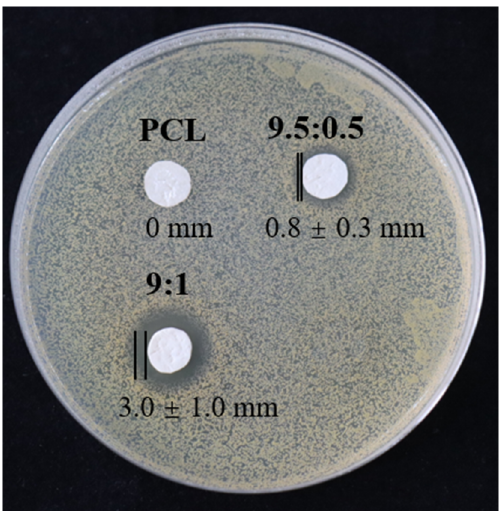
Figure 7. Antibacterial properties of nanofiber scaffolds spun from PCL and from solutions with different PCL/TA weight ratios (9.5:0.5 and 9:1).